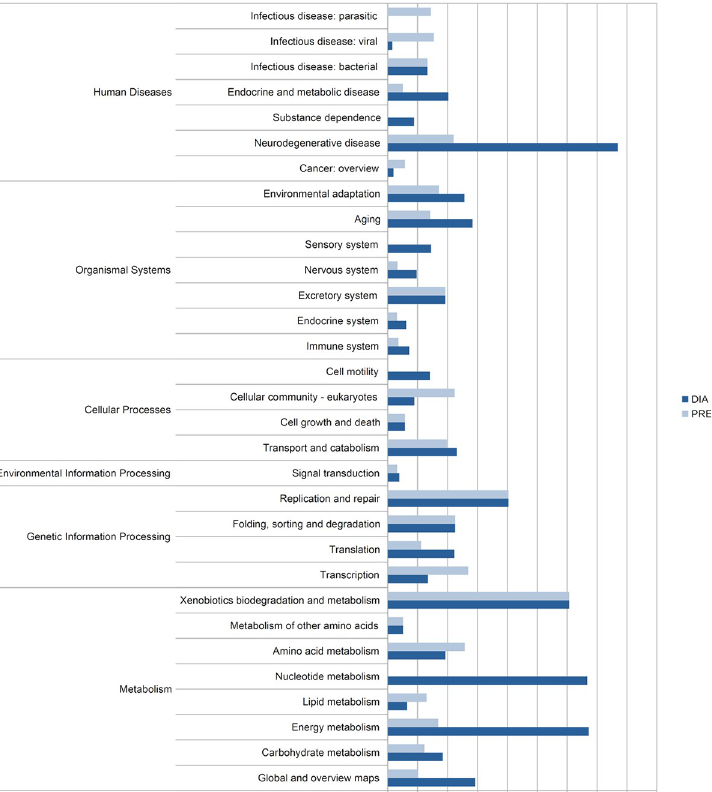
Fig 6. KEGG pathway analysis of upregulated proteins in prehatching (PRE) and diapause III (DIA). Bars indicate the proportion of proteins upregulated in each condition in relation to the total number of proteins of the entire proteome assigned to each pathway (PRE: light blue, DIA: blue). On the left side, the upper hierarchical category is shown. See S4 Table for details.